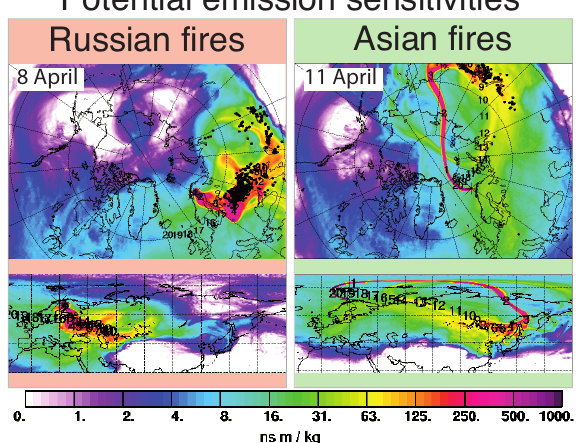
Fig. 10. FLEXPART column-integrated potential emission sensitiv- ities for Russian (left) and Asian (right) forest fire plumes. Black and red dots represent agricultural and forest fires,